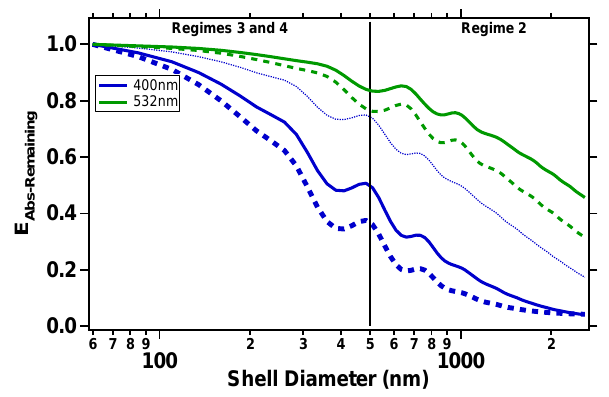
Fig. 6. Calculated E Abs − Remaining for a 60nm diameter BC core and varying C Brown shell diameters at 400nm and 532nm wave- length for high (thick dashed line), mid (solid black line) and low (thin dashed line) k Brown values corresponding to Fig.